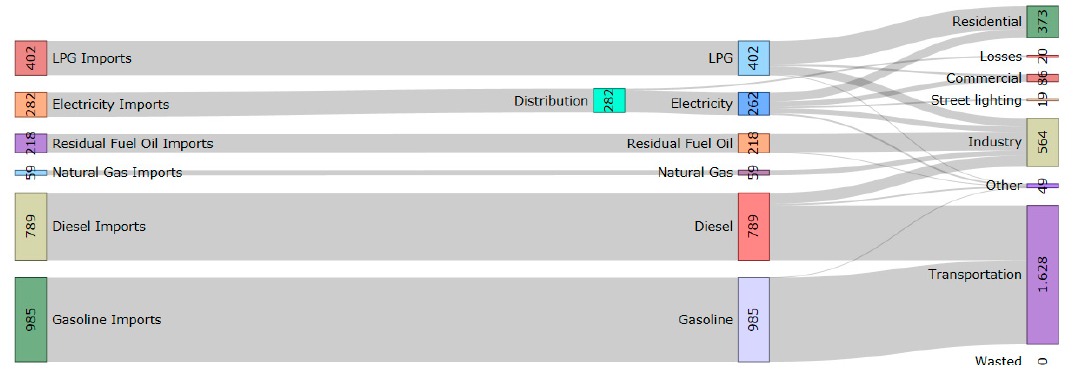
Figure 3. The Sankey diagram of the energy situation in Cuenca.